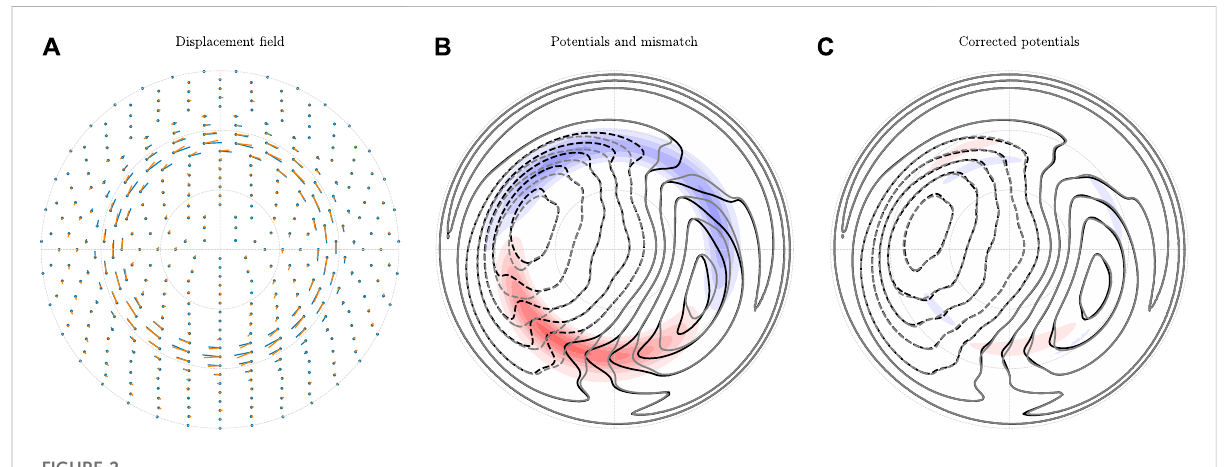
FIGURE 2 (A) The displacement fi eld from Figure 1B, together with displacement fi eld estimated using the technique described in Section 2 (orange pins). (B) The apparent potential mismatch that the displacement fi eld is based on (a copy of Figure 1C), (C) The remaining potential mismatch when the estimated displacement fi eld is taken into account in the comparison between hemispheres. The red-white-blue color scale is the same as in Figure